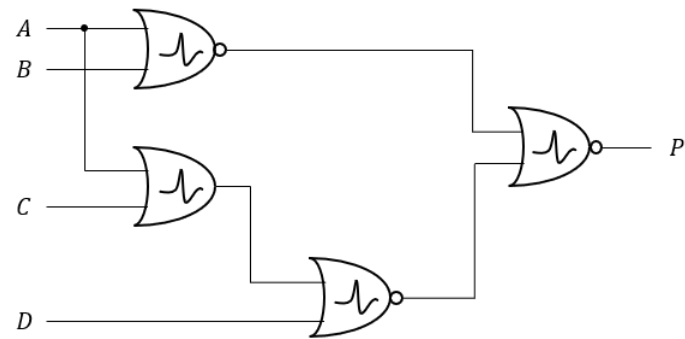
Figure 9. The structure of the 8421-BCD code rounding logic network.